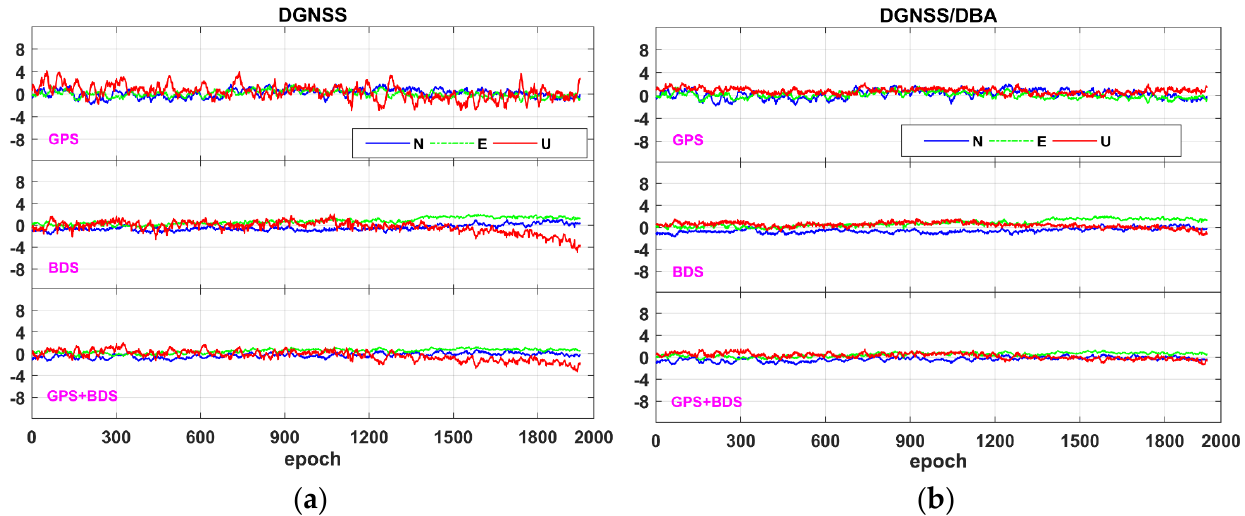
Figure 5. The deviation sequence diagram in the N/E/U directions at 10 − degree elevation mask angles: ( a ) DGNSS positioning mode; ( b ) DGNSS/DBA positioning mode.